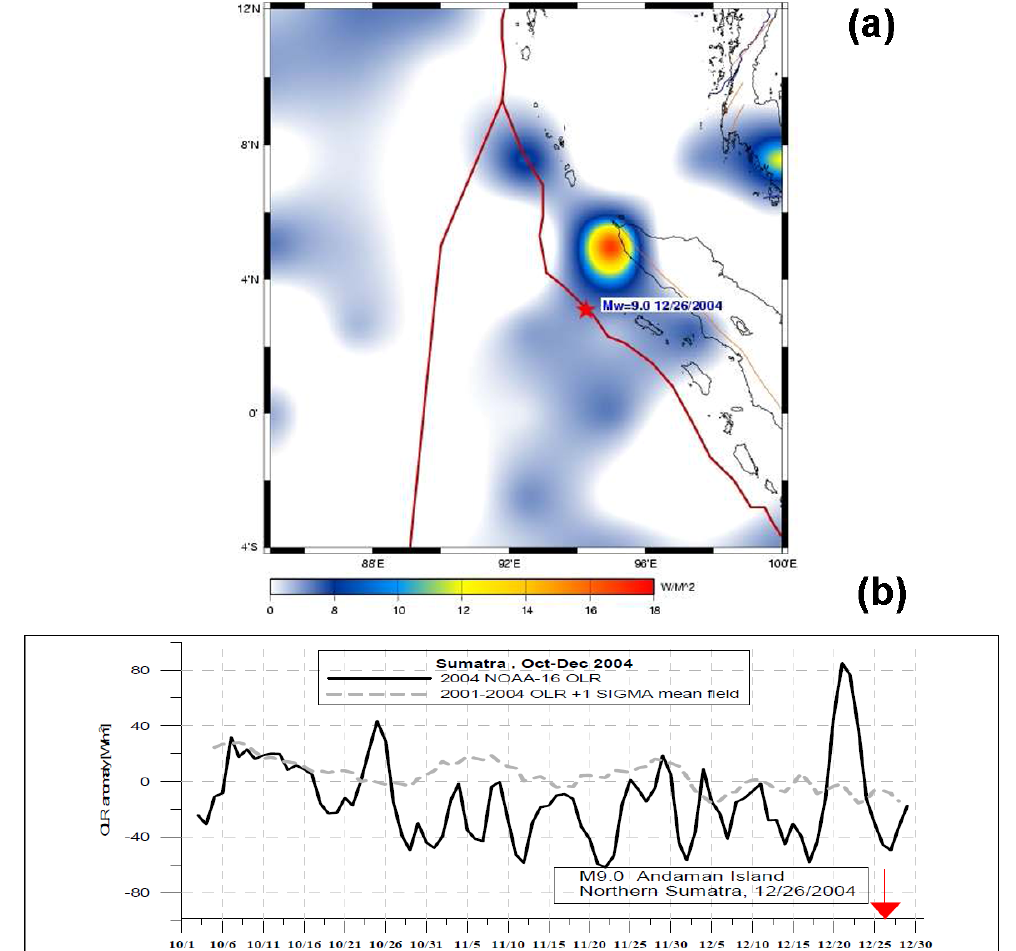
Figure 19. Outgoing longwave radiation anomaly for the Sumatra earthquake (M = 9.0, 26 December 2004, Indonesia). (a) Map of OLR monthly variations for November 2004, month prior to the shock. (b) Time-series of daily OLR anomaly for 1 October 2004–31 December 2004 over the epicenter